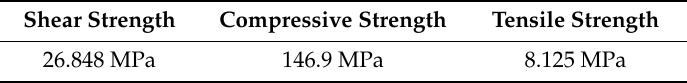
Table 1. Physical properties of limestone used in this study.